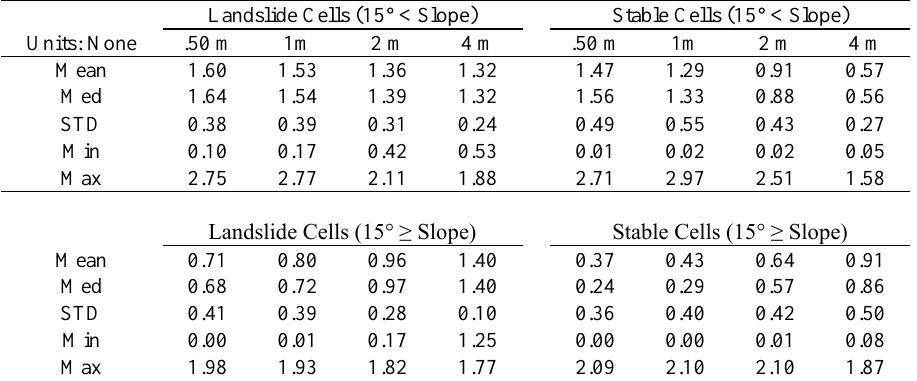
Table 3 . Statistics of ln(λ 1 /λ 2 ) eigenvalue ratios surface feature.